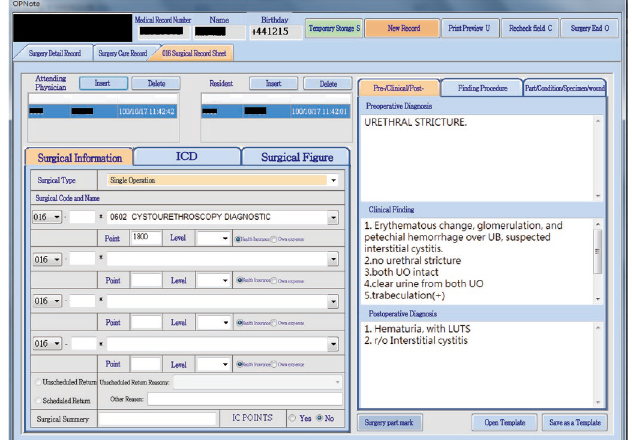
Figure 6. Reference - surgical record sheet